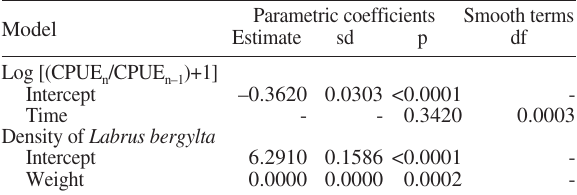
Fig. 4. – Partial effect of the catches in the spearfishing competitions on the abundance of Labrus bergylta obtained by UVCs. The obser- vations (points), the prediction (continuous lines) and their standard deviation (dashed lines) estimated by GAM are shown. Table 3. – Results of the GAM fitted to the rate of change of the CPUE between pairs of consecutive competitions and to the abundance of Labrus bergylta obtained by UVCs. The estimated parametric coefficients, the standard deviation (sd) and associated p value are shown. The degrees of freedom (df) of the smoothed terms was also